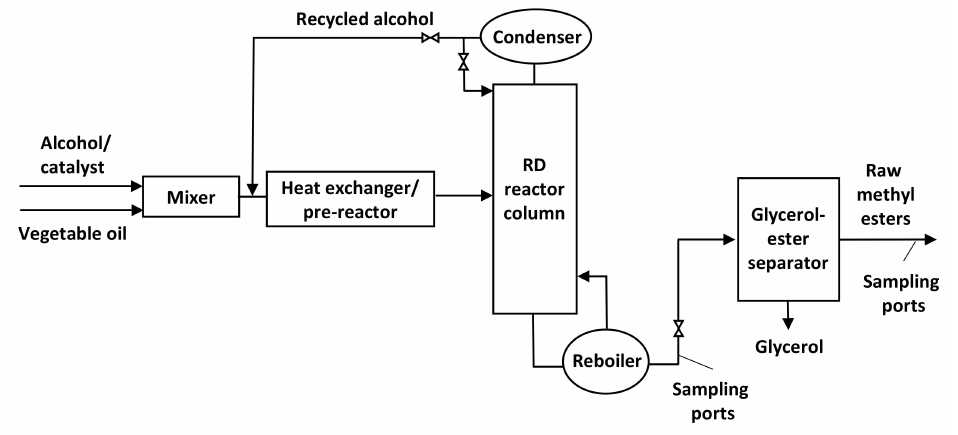
Figure 12. Continuous-flow reactive distillation